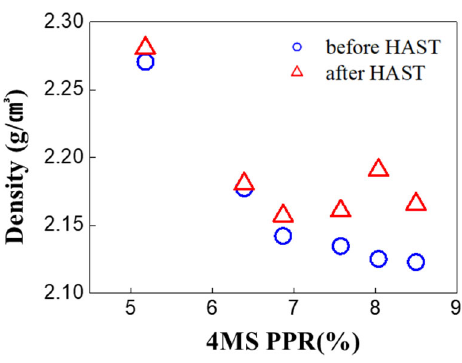
Figure 13. XRR analysis for film density according to the 4MS PPR before and after the HAST.